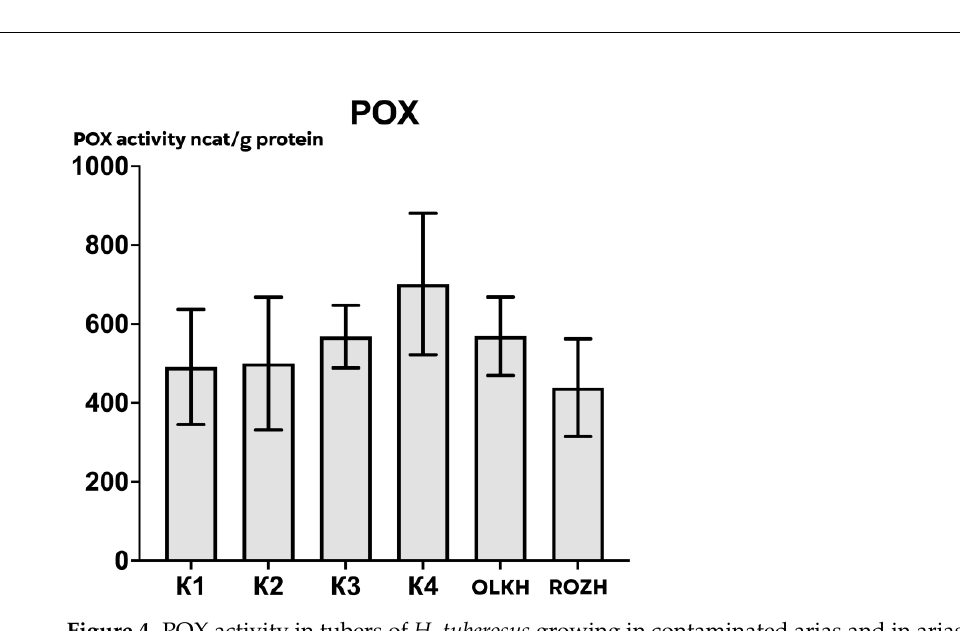
Figure 4. POX activity in tubers of H. tuberosus growing in contaminated arias and in arias without contamination.